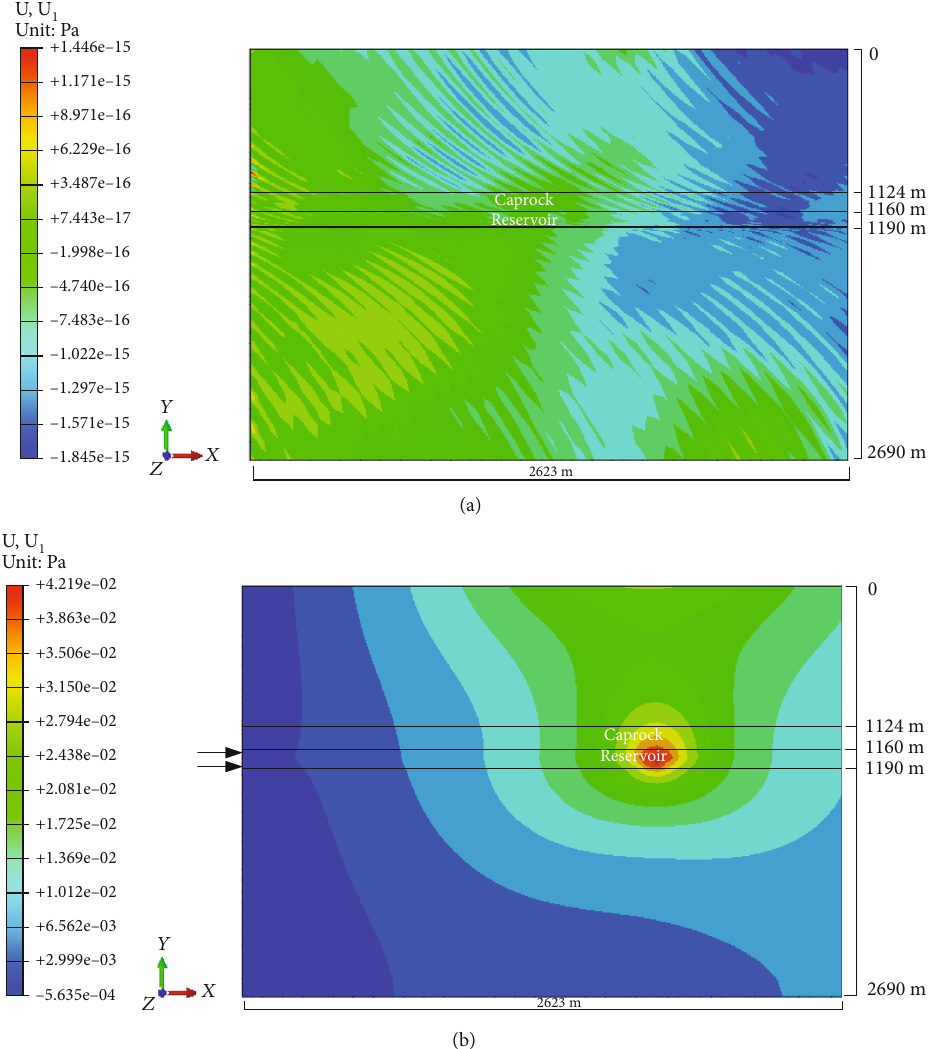
Figure 12: Horizontal displacement change nephogram. (a) Before injection. (b) After